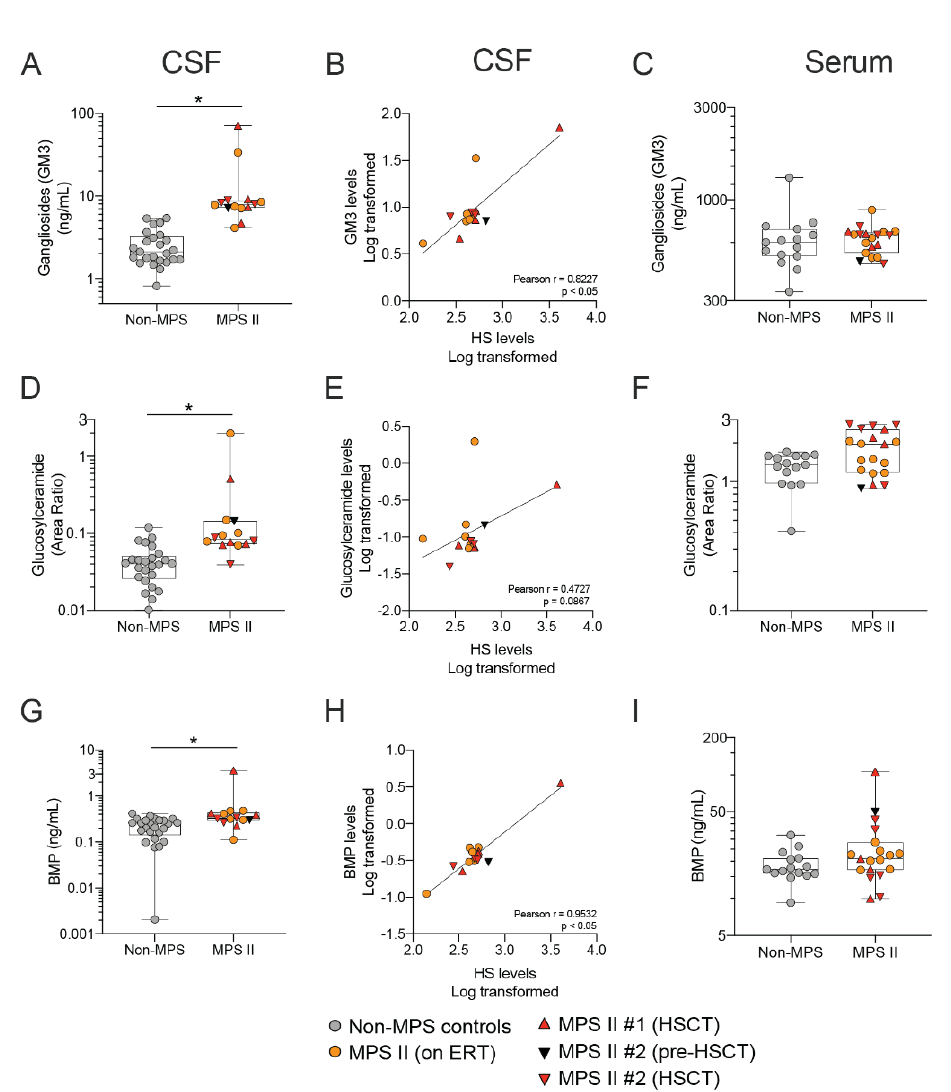
Figure 7. Elevated lysosomal lipid levels correlate with heparan sulfate levels in CSF of nMPS II patients. Lysosomal lipids such as Gangliosides GM3(d36:1) ( A – C ), Glucosylceramides (d18:0/20:0) ( D – F ), and BMP (18:1/18:1) ( G – I ) are quantified in CSF and serum of nMPS II patients and non-MPS controls using LC-